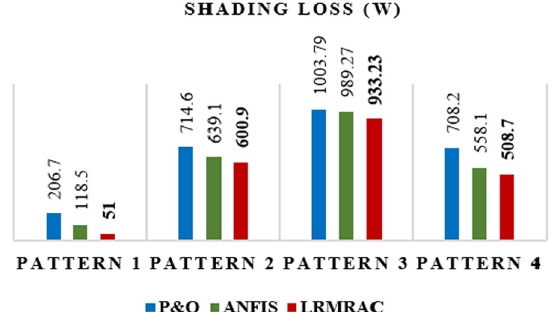
Table 6 Shading loss (W) in various MPPT approaches under